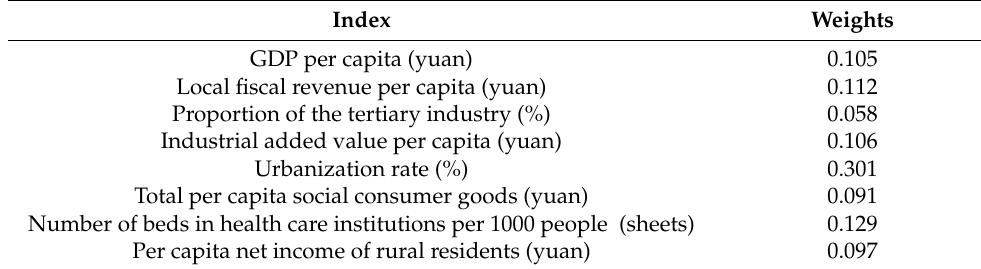
Table 3. Evaluation index system and weight of socioeconomic development